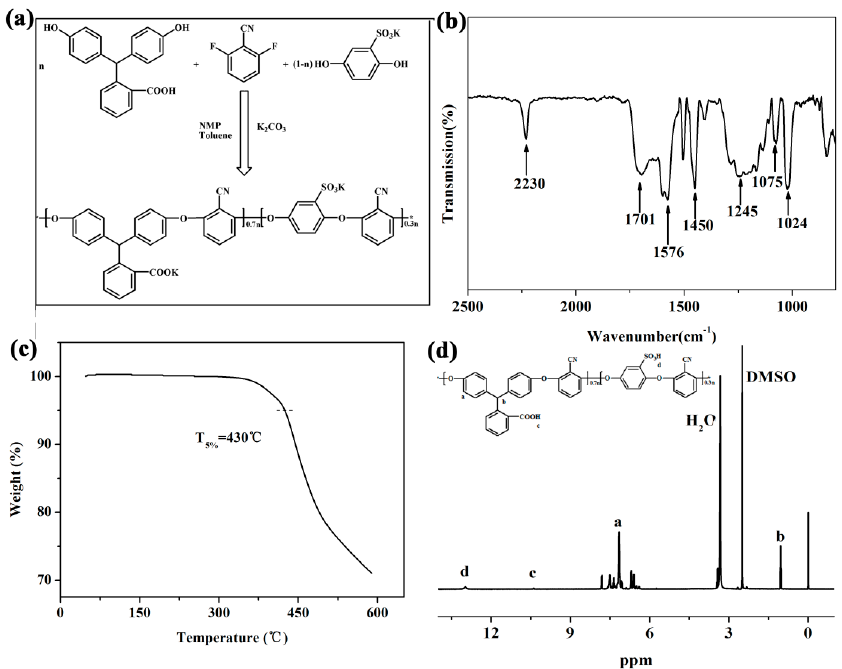
Figure 1. Synthesis route ( a ) FTIR ( b ), TGA curves and ( c ) 1 H NMR spectra ( d ) of raw sulfonated poly(arylene ether nitrile) (SPEN).